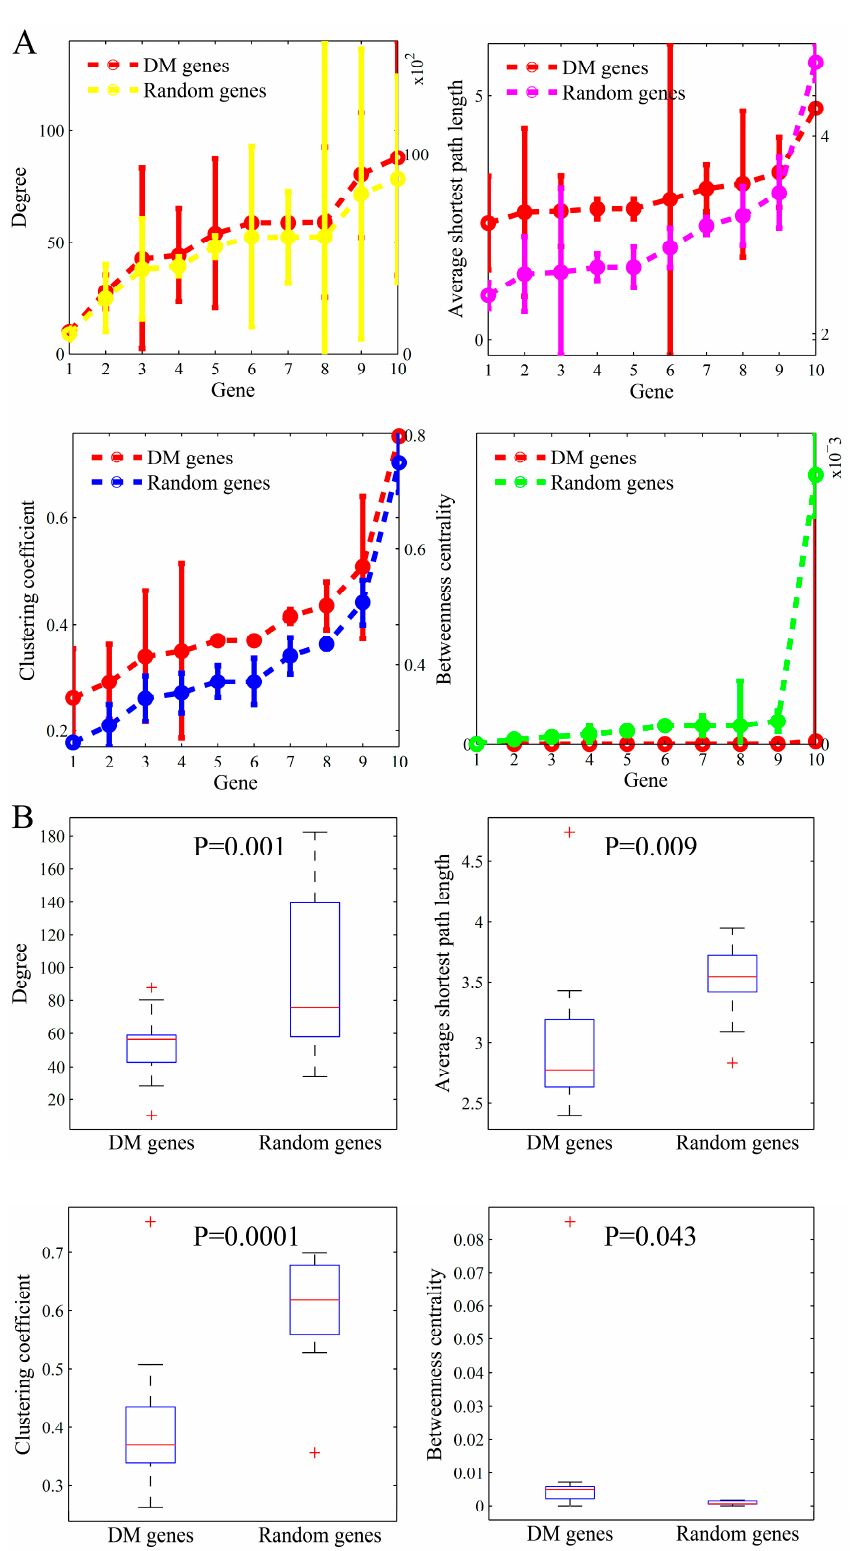
Figure 7. The comparison of topological parameters between DM (diabetes mellitus) genes and randomly-selected genes. ( A ) The means (left y-axis) and standard deviations (right y-axis) of the four parameters in the ten AD (Alzheimer’s disease) gene groups and those corresponding in the randomly-selected ten gene groups. ( B ) Boxplots of these parameters.